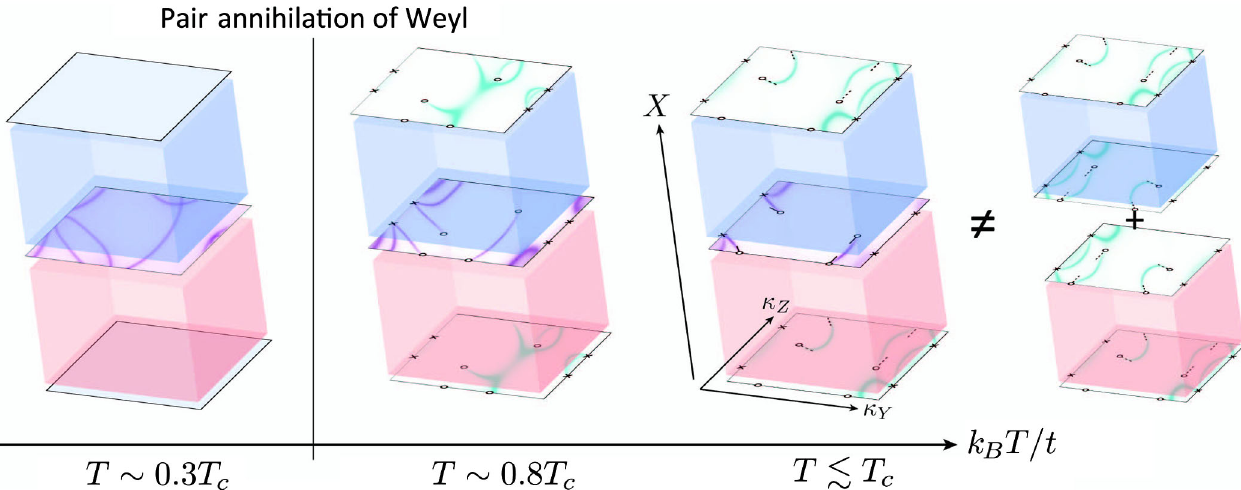
FIG. 1. Two-dimensional Brillouin zones illustrated for two different kinds of interfaces, namely, surfaces of bulk crystals with magnetic orders (red or blue transparent cubes) against vacua and domain walls between two magnetic domains. Evolution of Fermi arcs is shown for the surfaces between the bulk and vacua and for the magnetic domain walls between two magnetic domains upon changes in temperatures T (indicated by the horizontal axis). The evolution occurs in a zero-gap semiconductor hosting Weyl electrons below its critical temperatures for the magnetic order T . The domains with two inequivalent magnetic orders that are mapped onto each other c through the time-reversal operation are illustrated as the red and blue transparent cubes (called “ all-out ” and “ all-in ” domains in the later discussion). These surfaces and domain walls are illustrated to be perpendicular to the X axis. The spectral functions at the Fermi level ; κ are shown in the momentum frame ð κ with a finite broadening factor for the sake of illustration. Here, stronger colors indicates Y Z Þ higher spectral intensities. In contrast to the naive expectation that the magnetic domain walls simply consist of two surfaces between the bulk and vacua (shown in the right end), the magnetic domain wall offers a novel two-dimensional interface distinct from the surfaces: Even after pair annihilation of the Weyl electrons, the domain-wall metallic states remain and form a Fermi surface (shown in the left end panel). All of the Fermi arcs (and the Fermi surface at lowest temperatures) are calculated by using the tight-binding Hamiltonian (1) 01¯1 with the ð Þ surfaces and domain walls introduced later, with the parameter set used for Figs. 3 and 6. For detailed notations, see